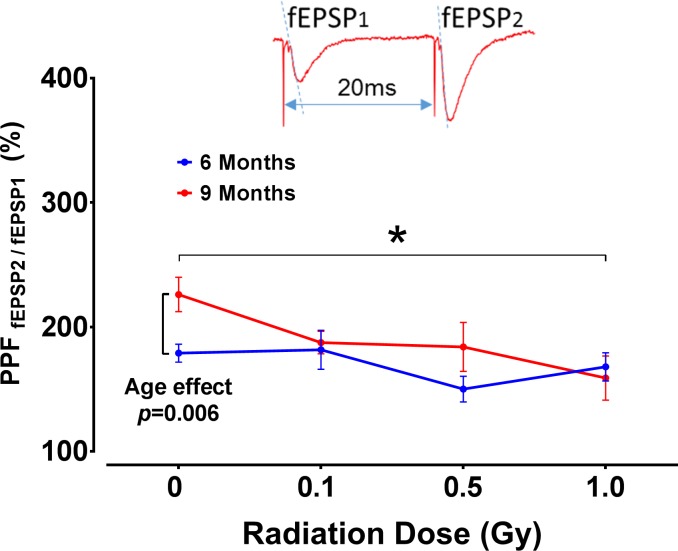
Radiation effects on age-related increase of PPF in TG mice.Comparison of PPF between at 6 and 9 months in TG mice revealed significant interaction between radiation dose and post-irradiation time point with enhanced PPF in 9-month TG control group only. Age increased PPF in control TG mice, and all doses of radiation reduced such PPF increases to the level observed in control TG mice at the 6-month time point. Significant reduction in PPF was detected at 1 Gy only. Inset: Original voltage trace at 20 ms inter-stimulus interval showing facilitated slope of the 2nd fEPSP (fEPSP2). Arrowheads indicate stimulation artifacts. Note that the graph indicates PPF values acquired at 20 ms only (strongest PPF effect); however, the statistical model included PPF recorded at all ISIs. 6-month group: N = 11, 11, 8 and 10 slices/radiation group; 9-month group: N = 12, 15, 7 and 10 slices/radiation group. Statistical analyses: RM ANOVA, Post hoc tests * p<0.05, ** p<0.01. Data represent mean ± SEM.